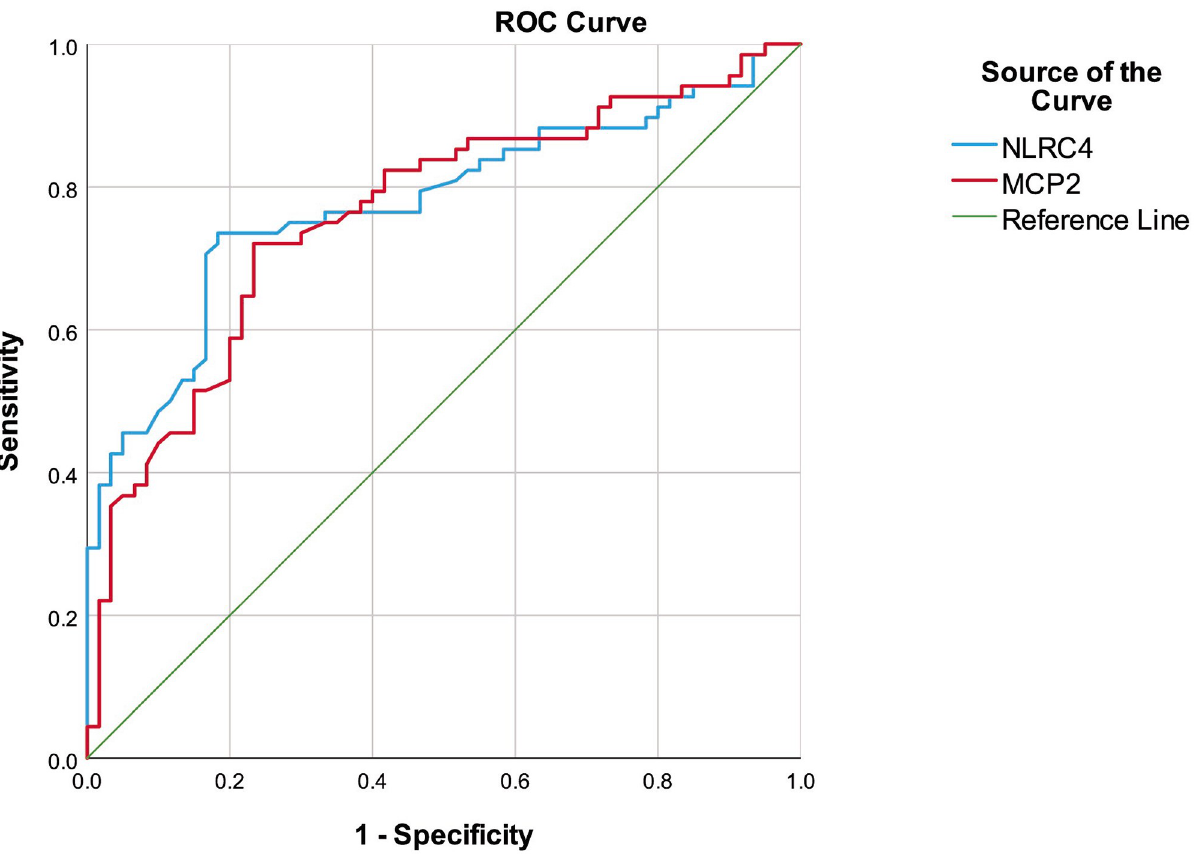
Fig 1. ROC analysis of the NLRC4 and MCP2/CCL8 to determine active Crohn’s disease. ROC: Receiver operating characteristics, NLRC4: Nucleotide-binding and oligomerization domain-like receptor family CARD domain-containing protein 4, MCP2: Monocyte chemotactic protein 2.